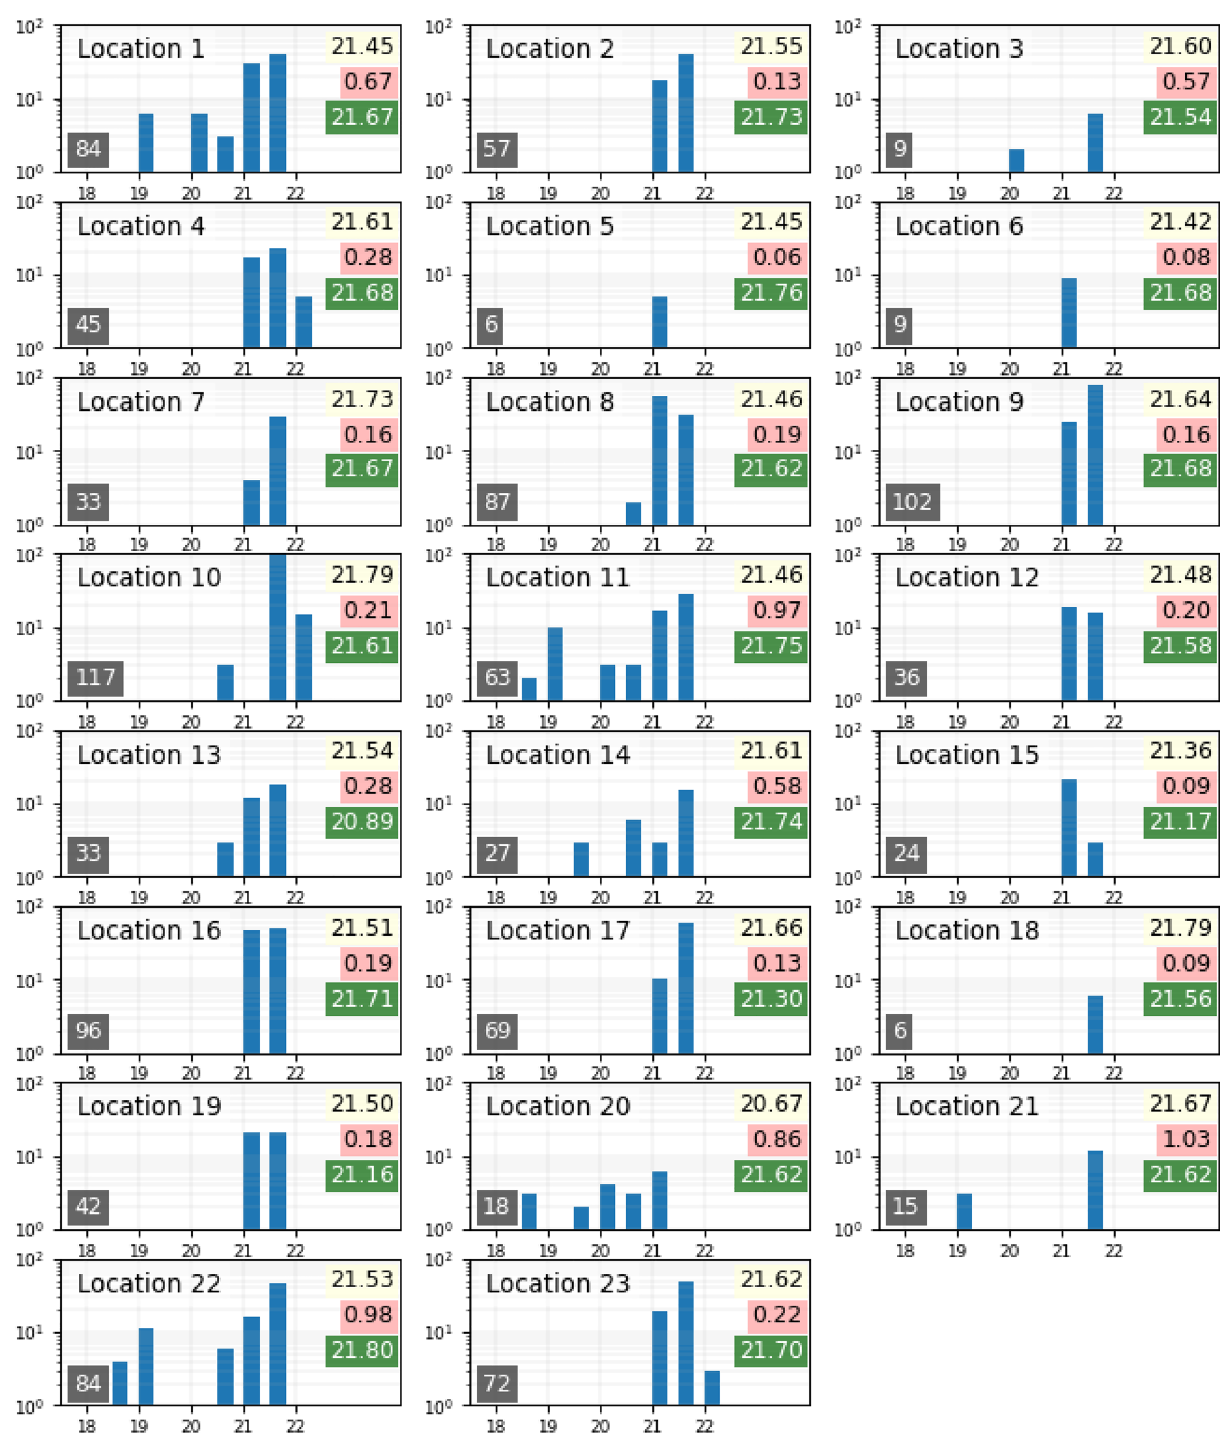
Figure 1. NSB histograms of 1134 individual SQM measures performed at 23 different sites in the French Parc Naturel Régional de Millevaches-en-Limousin in 2019 and 2020. The horizontal axis is made of 8 NSB bins from 18 to 22 mag SQM /arcsec 2 , each one being 0.5 mag SQM /arcsec 2 wide. The vertical axis is logarithmic and ranges from 1 to 100 measures. The number of SQM measures on each site is reported in the lower left corner of the histogram, the median NSB is in the upper right corner with a yellow background, the standard deviation for each data set is provided in a red frame and finally the predicted NSB value is provided in a green